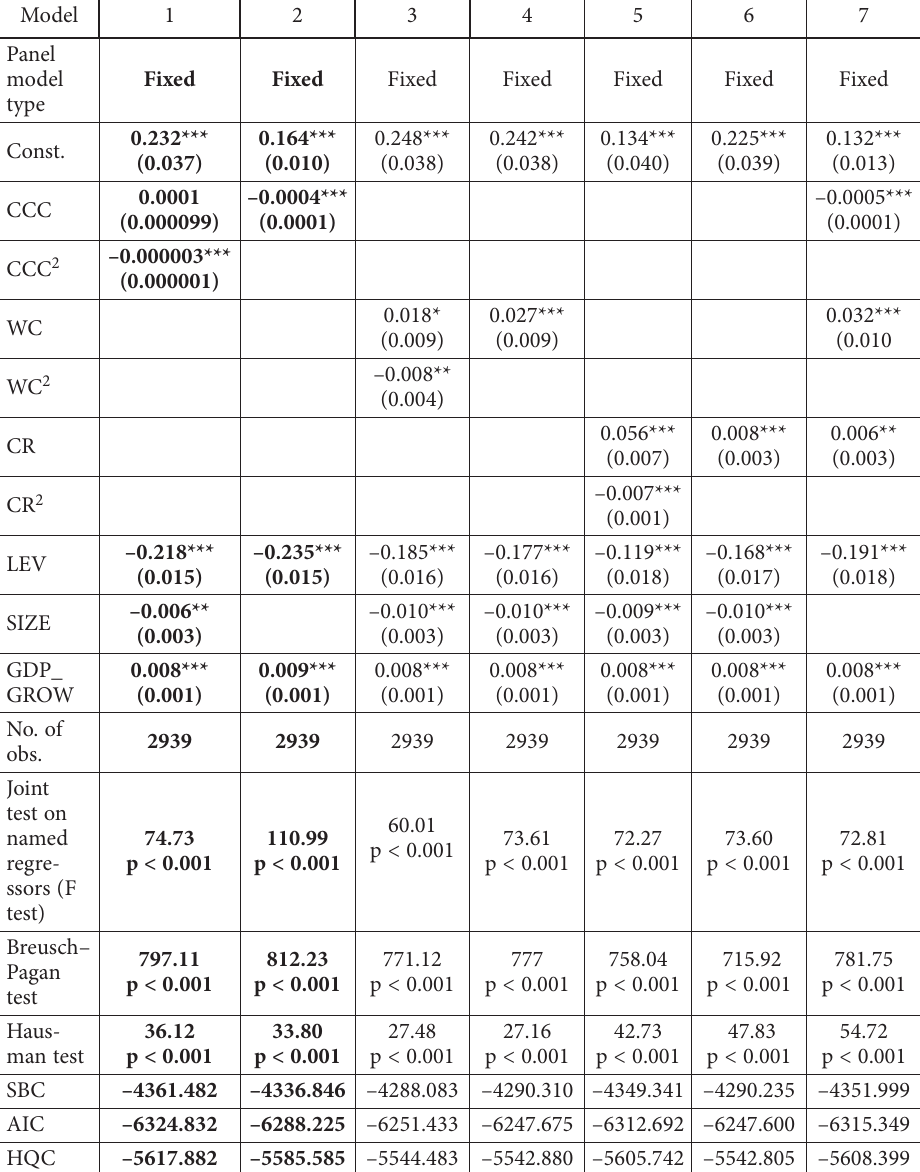
Table 6. Results of model estimation (full sample) (source: own